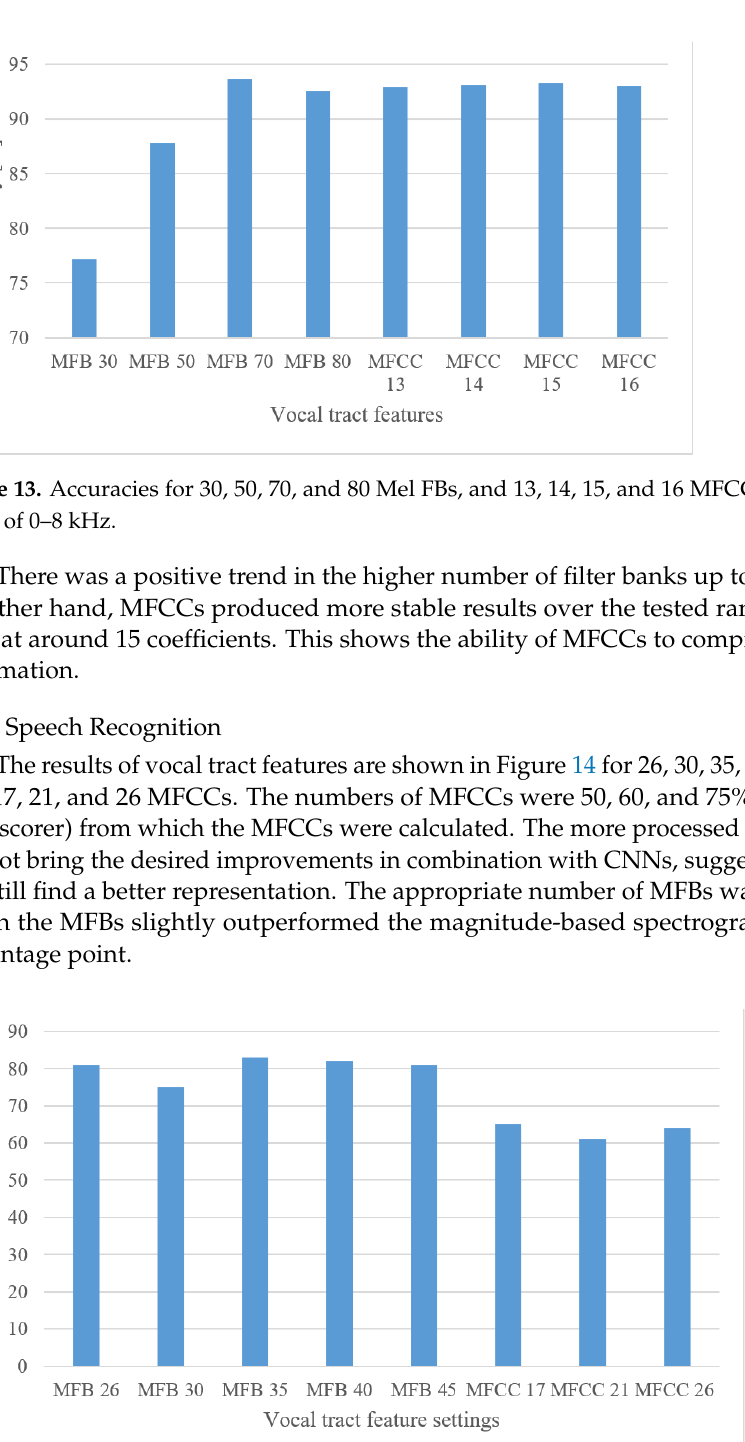
Figure 12. Averaged accuracies for 30, 45, and 60 MFBs, and 10, 13, 16, and 19 MFCC coefficients for an 8 kHz maximal frequency.